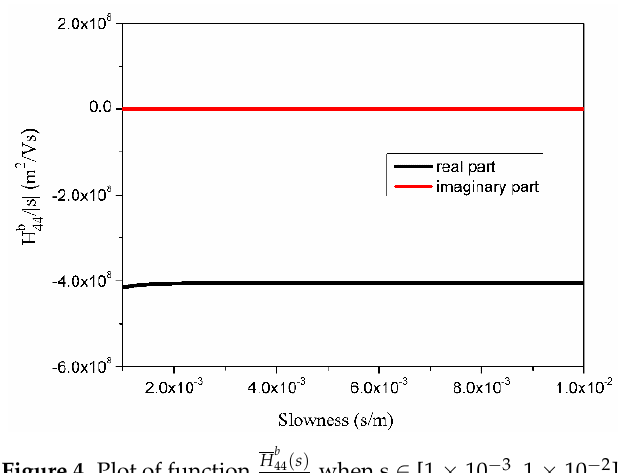
Figure 4. Plot of function H